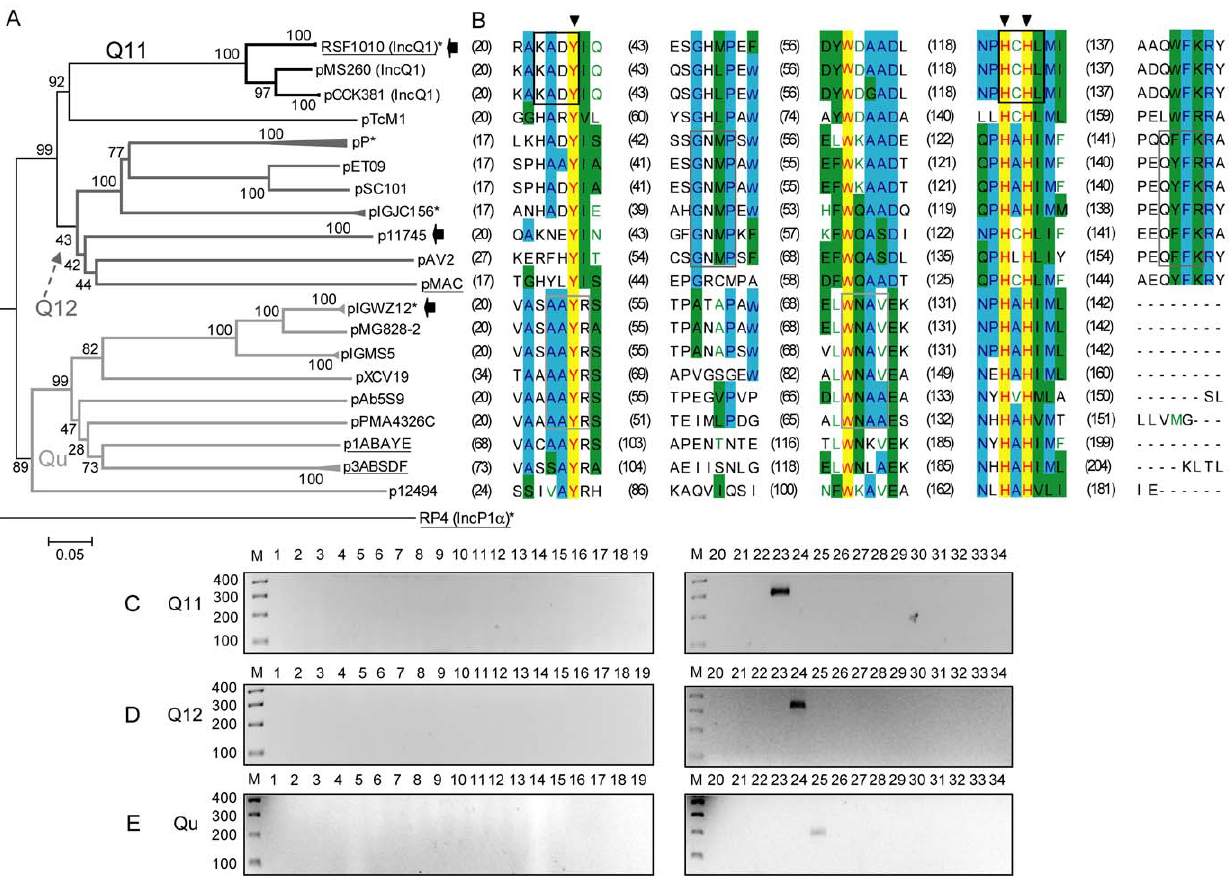
Figure 5. DPMT validation for MOB Q relaxases. A) Phylogenetic tree of MOB Q relaxase family. B) Alignment of the relaxase motifs used to design the MOB Q degenerate primers (Q11-f + Q11-r, continuous black; Q12-f + Q12-r, continuous dark grey; and Qu-f + Qu-r, continuous grey). C) Amplicons obtained with primers for subfamily MOB Q11 (Q11-f and Q11-r). D) Amplicons obtained with primers for subfamily MOB Q12 (Q12-f and Q12- r). E) Amplicons obtained with primers for subfamily MOB Qu (Qu-f and Qu-r). Symbols, colour codes and lanes as in Figure 1.